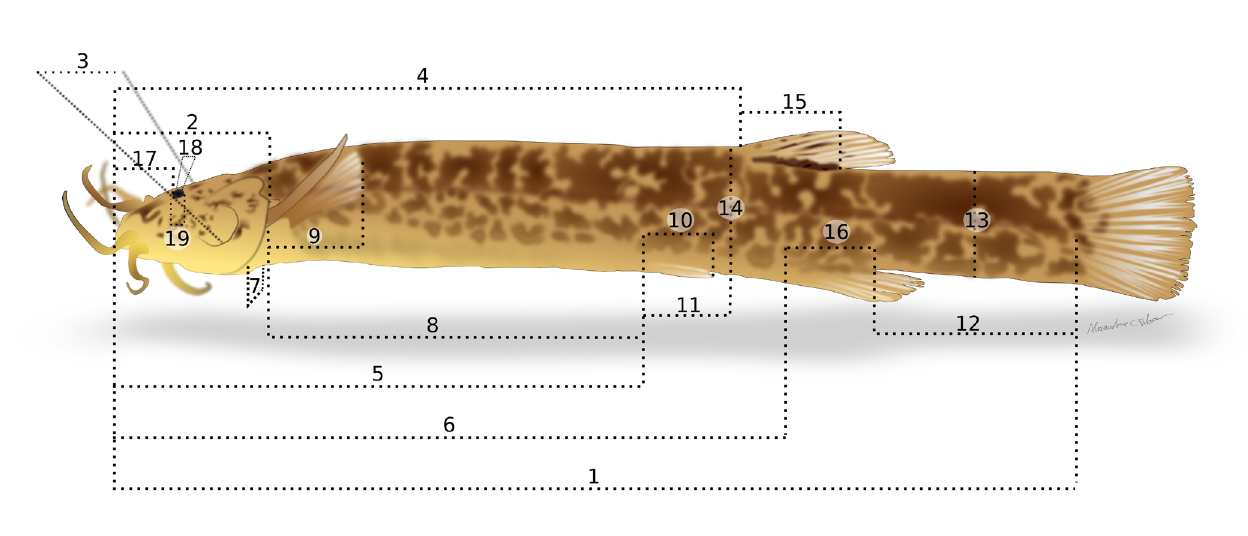
FIGURE 2 | Schematic drawing of morphometric measurements applied to Cambeva species: (1) standard length, (2) head length, (3) head width, (4) predorsal length, (5) prepelvic length, (6) pre-anal length, (7) scapular girdle width, (8) trunk length, (9) pectoral-fin length, (10) pelvic-fin length, (11) distance between pelvic-fin base and anus, (12) caudal peduncle length, (13) caudal peduncle depth, (14) body depth, (15) length of dorsal-fin base, (16) length of anal-fin base, (17) snout length, (18) interorbital distance, and (19) eye diameter. Illustration made by Alexandre